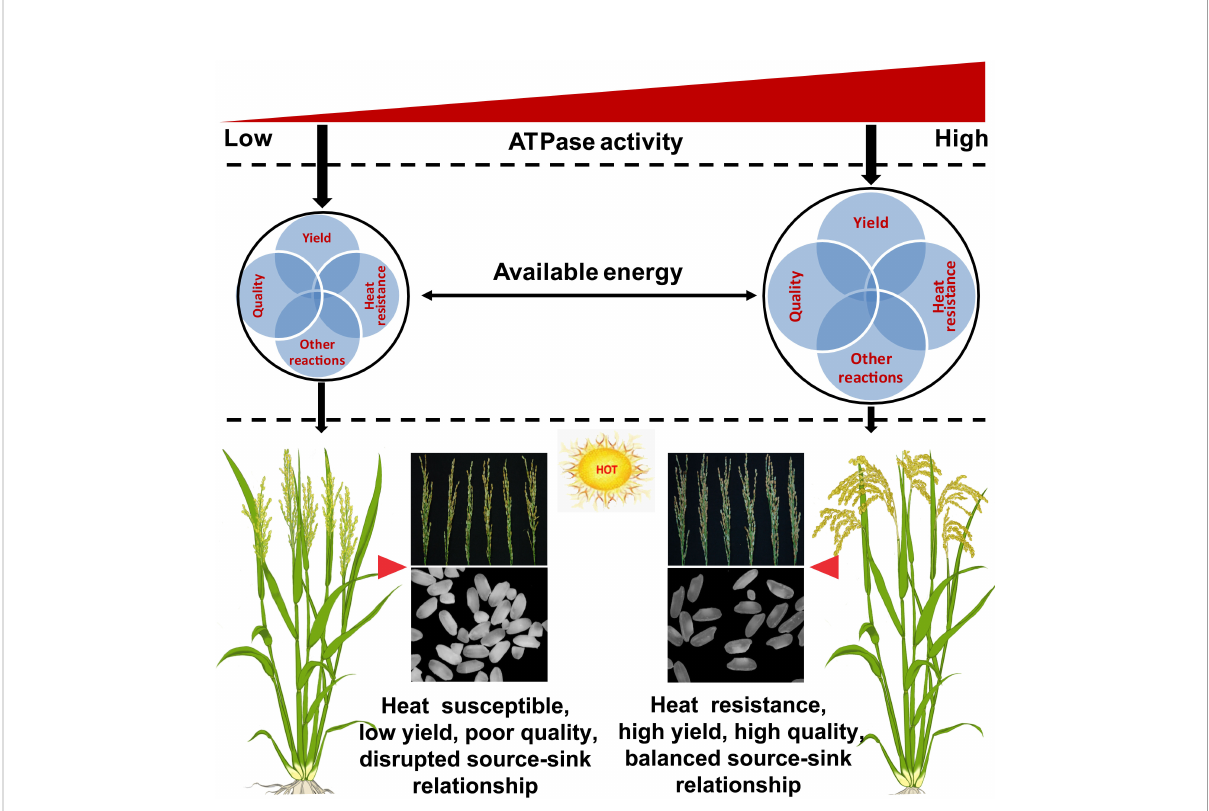
FIGURE 7 Model of energy status determined by ATPase functioned in heat resistance, yield and quality of rice under moderate hot conditions. Under moderate hot condition, heat resistance, high yield and good quality were showed in ZLY30, while heat susceptible, low yield and poor quality were showed in LLY35. This was mainly ascribed to the higher available energy determined by ATPase activity, rather than the ATP de fi cit, as higher ATP content were showed in LLY35 than ZLY30. Higher ATPase activity could enlarge the available energy to provide suf fi cient energy for the formations of heat response, yield and quality, which were considered as high energy cost processes. In contrast, lower ATPase activity could limit the available energy resulting in heat susceptible, low yield and poor quality. Furthermore, energy de fi cit could block the sucrose unloading in grains, which disorder the source-sink relationship. This in turns exacerbated energy shortage. The black circle means the available energy determined by ATPase. The four grayish blue circles mean the processes of heat resistance, yield, quality and other reactions including sucrose transportation, nitrogen metabolism, and protein